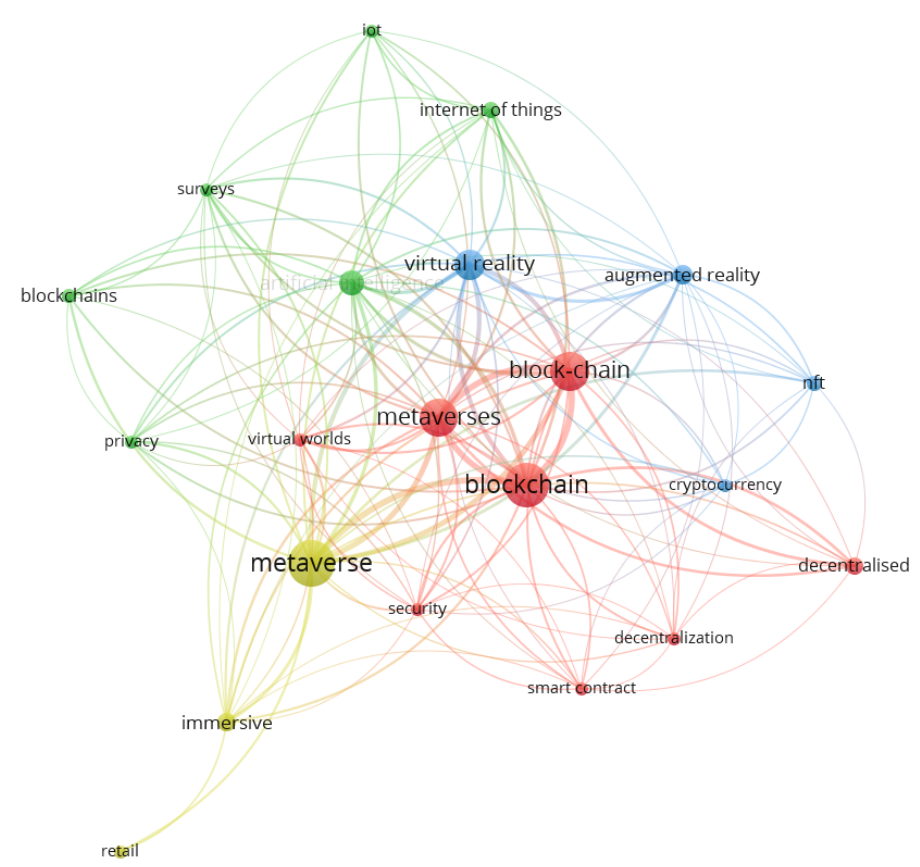
Figure 13. Keyword network for “blockchain” and “metaverse.”